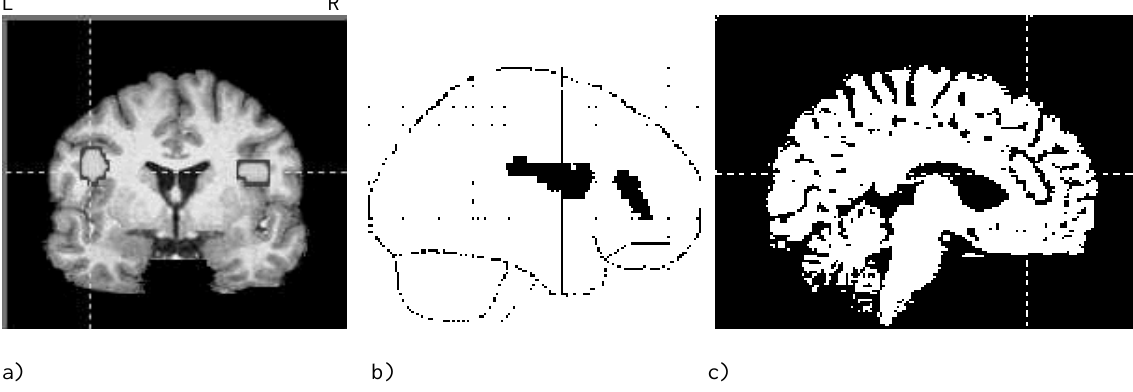
Fig. 1. A statistical parametric map of significant CBF decreases (anterior cingulate, K = 138 voxels, Z max = 3 . 74 ( x,y,z ) = 2 , 32 , 24 , BA 32 and bilateral pre-motor cortex, K = 230 voxels, Z max = 4 . 22 , ( x,y,z ) = − 46 , − 6 , 28 , BA 6 / 9 ; K = 223 voxels, Z max = 4 . 05 ( x,y,z ) = 40 , 6 , 24 , BA 6 / 9 ) in the first episode schizophrenic patients compared with controls is shown in Fig. 1(b). This is superimposed onto an anatomically standardised T1 MR image to facilitate visualisation (Figs (a) and (c)).